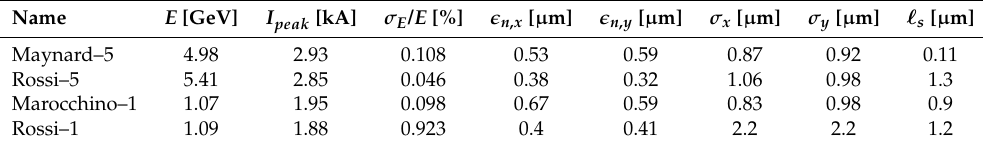
Table 1. Highest current density slice values of the relevant parameters at plasma